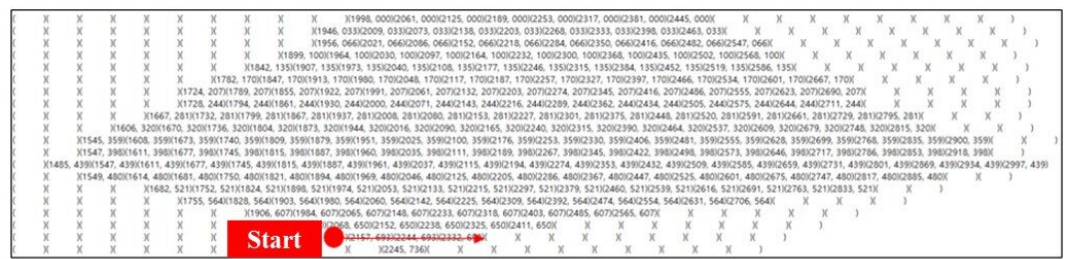
Figure 6. An example of the mapping of the AR marker IDs and ship block component IDs.